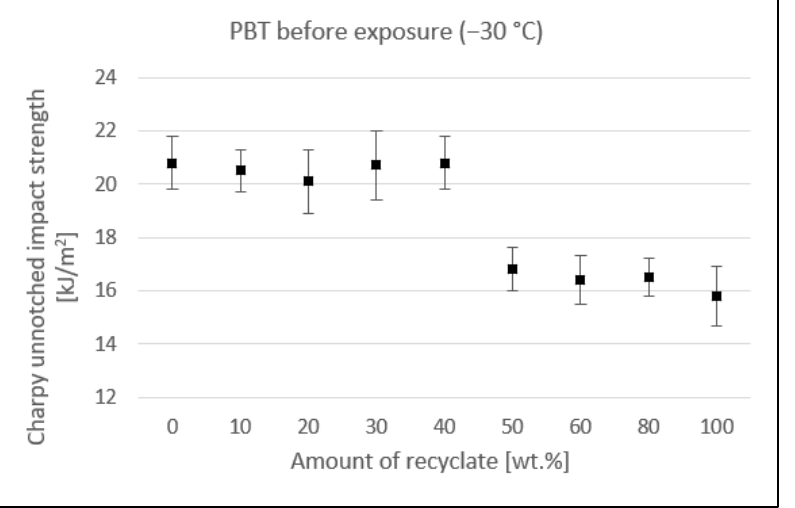
Figure 4. Dependence of the unnotched impact strength of PBT on the amount of recycled material before the samples were exposed to elevated temperature ( − 30 °C).